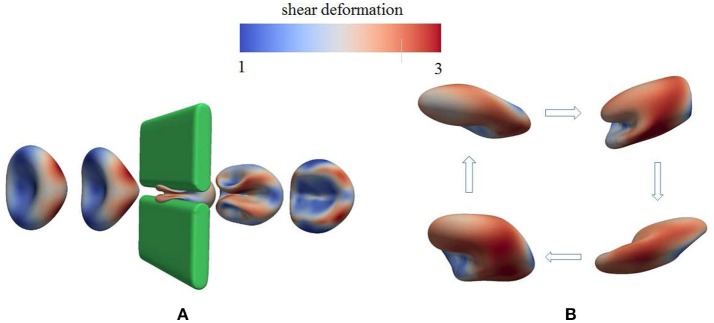
Occurrence of membrane infolding in (A) splenic flow (Salehyar and Zhu, 2016) and (B) oscillatory shear flow. In (B) the cytosolic/medium viscosity ratio was 1; the average shear stress applied to the cell was in the range τ¯~6Pa. The peak shear rate is 1,000 s−1, and the frequency is 67 Hz. In both figures the color contour corresponds to shear deformation χ (see section 3.2 for the definition of χ) of the skeleton with the value ranging from 1 (in blue) to 3 (in red). χ = λ1/λ2 with λi, i = 1, 2 being the principal skeletal stretches (see section 3.2).